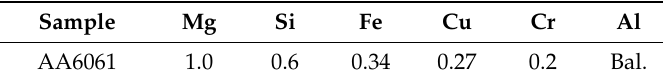
Table 1. Composition of AA6061 Al alloy